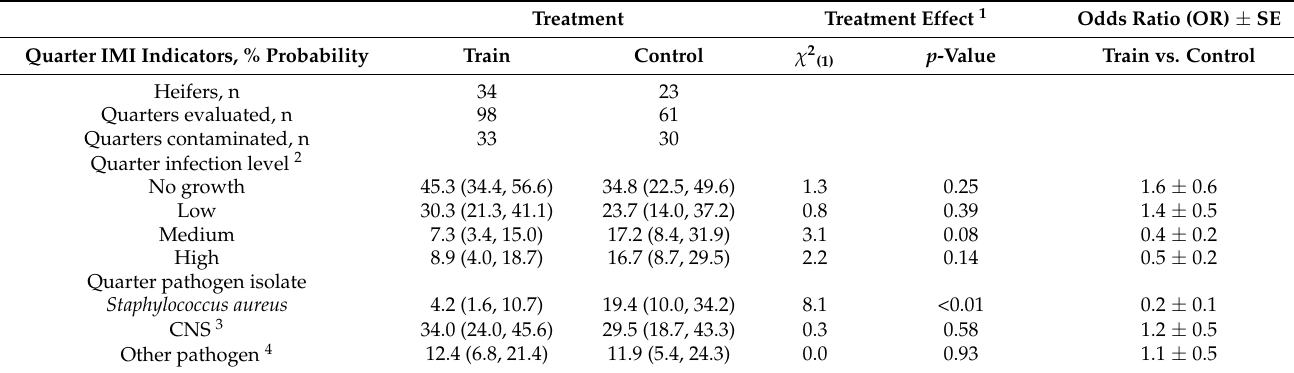
Table 4. The probability (95% CI) of quarter IMI and pathogens isolated in milk within 36 h after calving in heifers